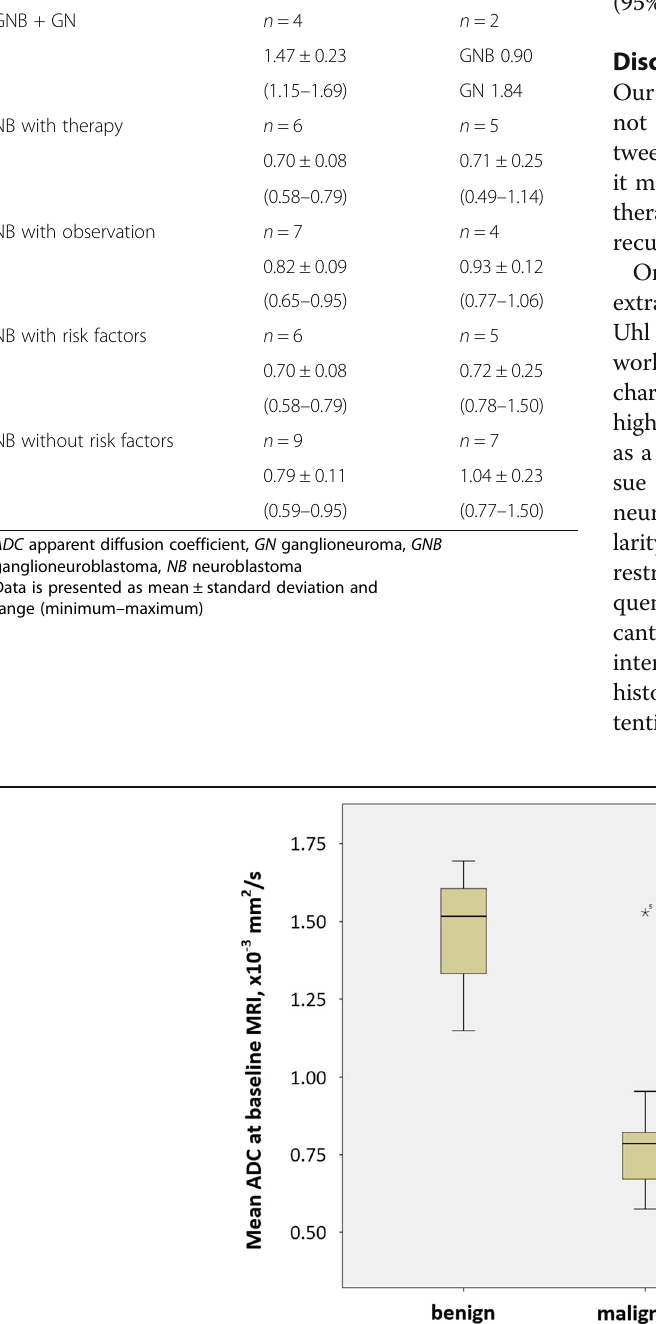
Fig. 4 Boxplot of mean tumour ADC of benign lesions (ganglioneuroma, GN, n = 3), malignant lesions (neuroblastoma, NB, n = 15; ganglioneuroblastoma, GNB, n = 1) and untreated metastases ( n = 6) at baseline. The one outlier in the category “ malignant ” represents the one case of malignant GNB in our